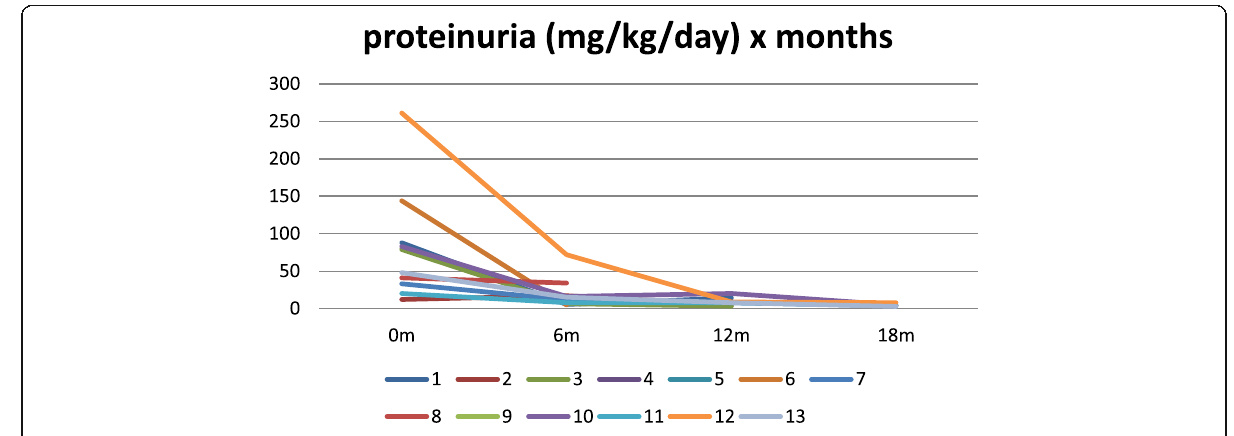
Fig. 1 Follow-up of proteinuria (mg / kg / day) of thirteen patients on azathioprine.